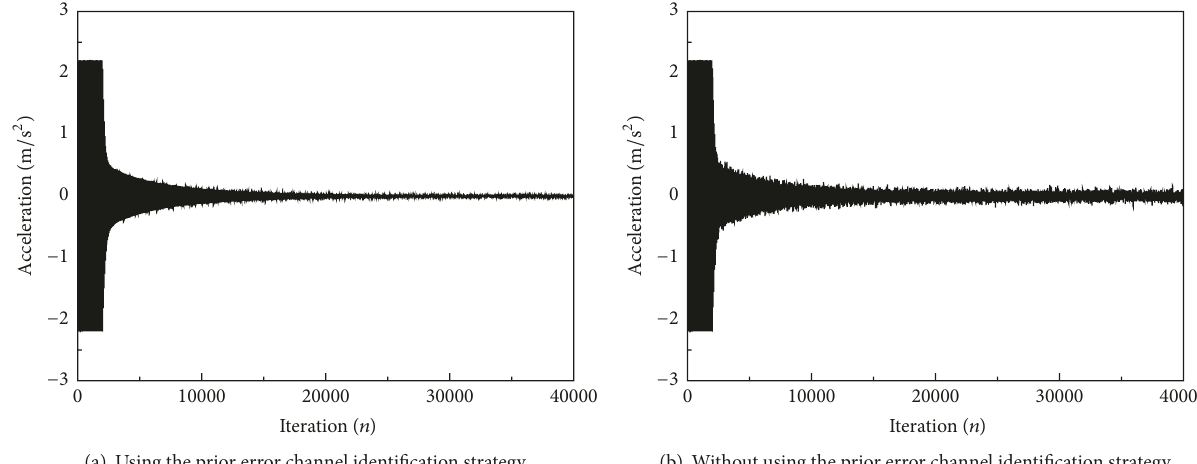
Figure 9: Acceleration of the controlled point of proposed method.